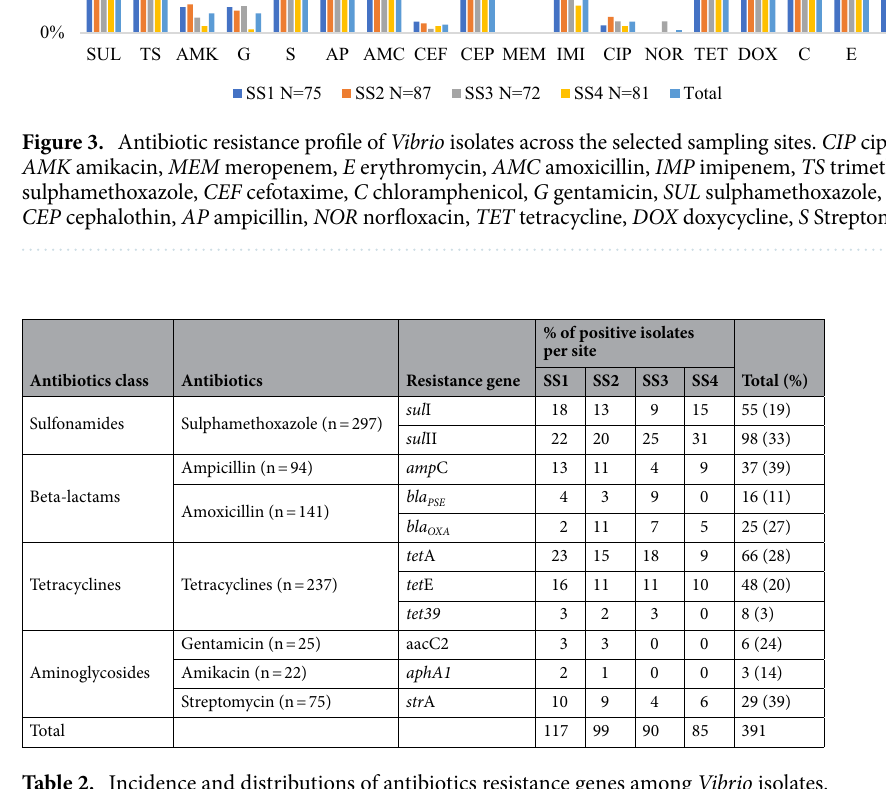
Table 2. Incidence and distributions of antibiotics resistance genes among Vibrio